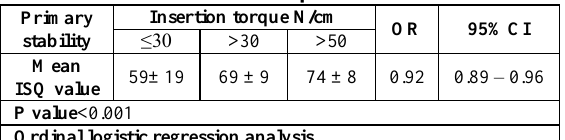
Table 3:Distribution and mean PIT and ISQ of the implants by bone type Bone type